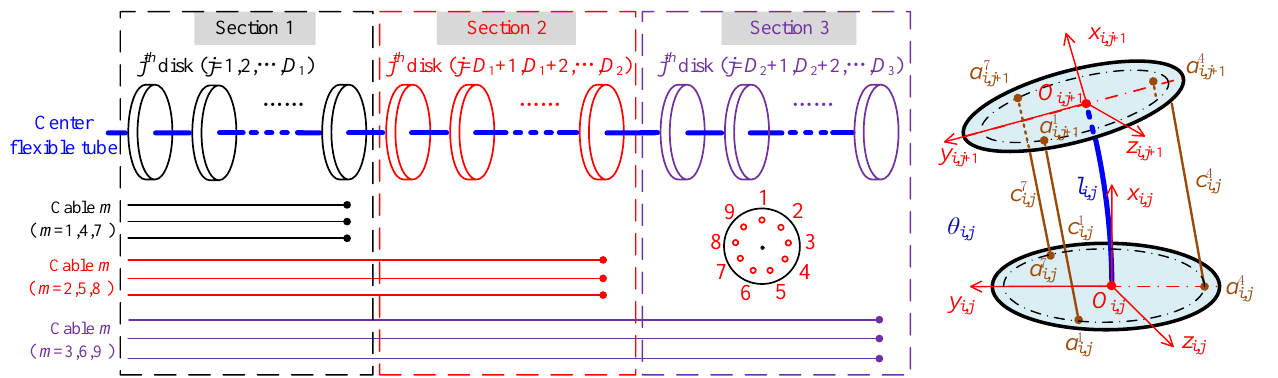
Figure 7. Geometric relationship of the j th segment on the i th section.